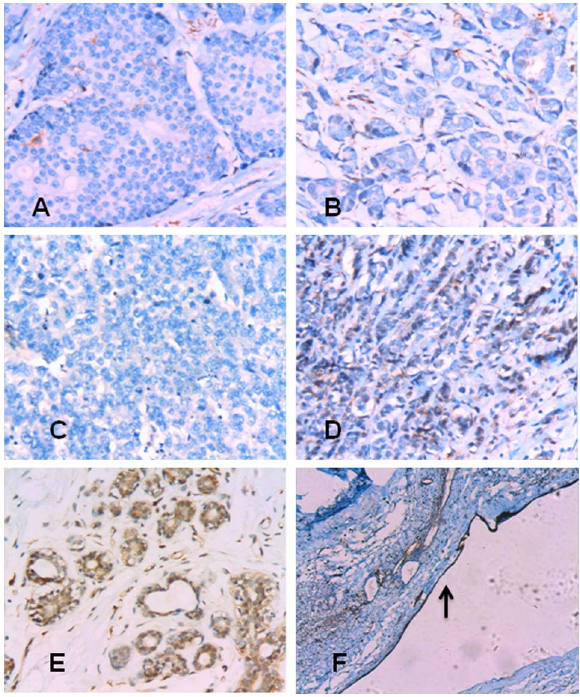
Figure 1. Expression of Dab2 in breast cancer specimens. (A) Ductal carcinoma in situ with microinvasion showing underexpression of Dab2 (original magnification 6 200). (B) Invasive ductal carcinoma showing underexpression of Dab2 ( 6 200). (C) Invasive lobular carcinoma showing underexpression of Dab2 ( 6 200). (D) Medullary carcinoma cells showing partial Dab2 positivity (cytoplasm; 2 + ) ( 6 200). (E) Normal breast epithelial cells showing strong Dab2 positivity in the cytoplasm ( 6 200). (F) Epithelial cells in a galactocele served as positive control (arrows indicate positive cells) ( 6 50).